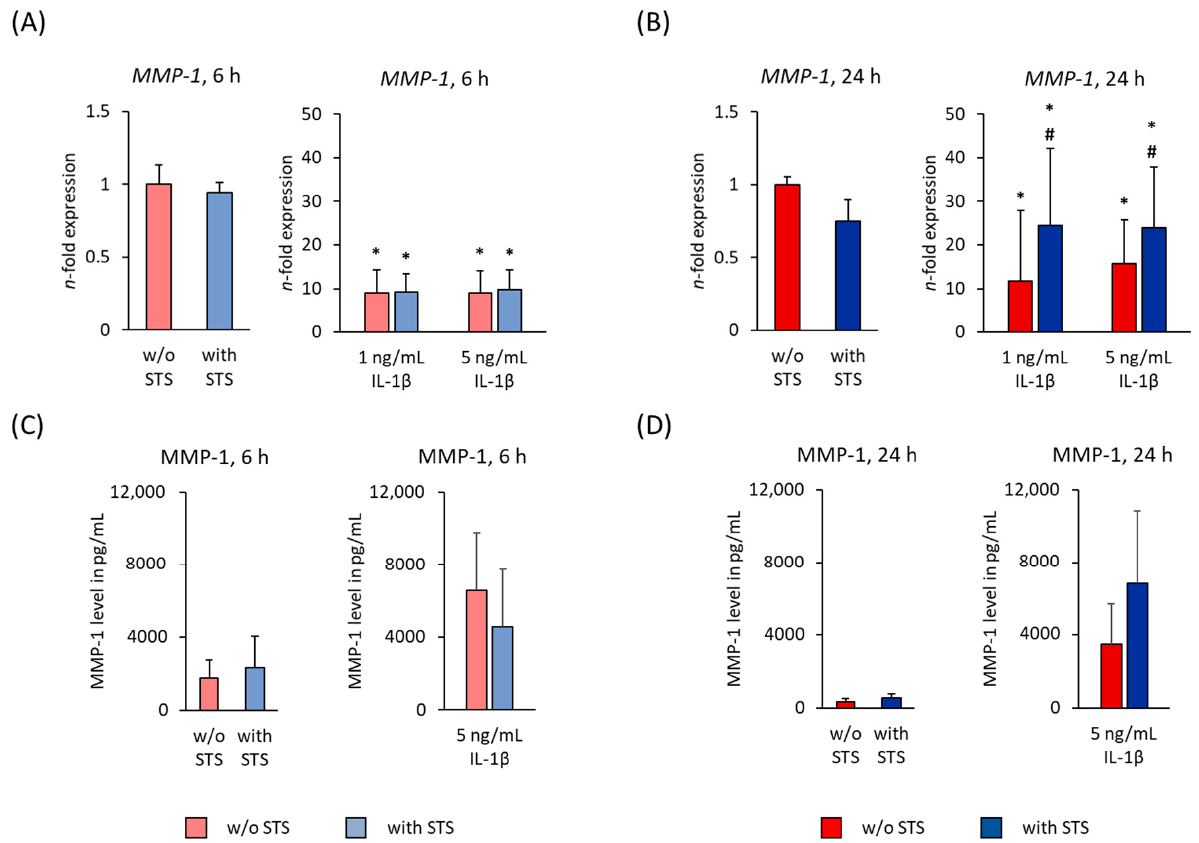
Figure 2. Effect of static orthodontic tensile forces on the IL-1 β -induced gene and protein expression of MMP-1 in hPDL-MSCs in the absence of FBS. STS with 6% equibiaxial elongation was applied to untreated or IL-1 β -treated hPDL-MSCs in the absence of FBS. 6 ( A ) and 24 ( B ) hours after stimulation with or without STS, qPCR was performed showing the n -fold expression levels of MMP-1 compared to the appropriate controls ( n -fold expression = 1). GAPDH served as an endogenous control. Corresponding MMP-1 protein levels were determined in pg/mL by enzyme-linked immunosorbent assay (ELISA) in conditioned media, which were harvested 6 ( C ) and 24 ( D ) hours after stimulation with or without STS. All data are presented as mean ± standard error of mean (S.E.M.). * p -value ≤ 0.05 significantly higher compared to the appropriate control; # p -value ≤ 0.05 significantly higher compared to the appropriate IL-1 β stimulated cells without static STS.